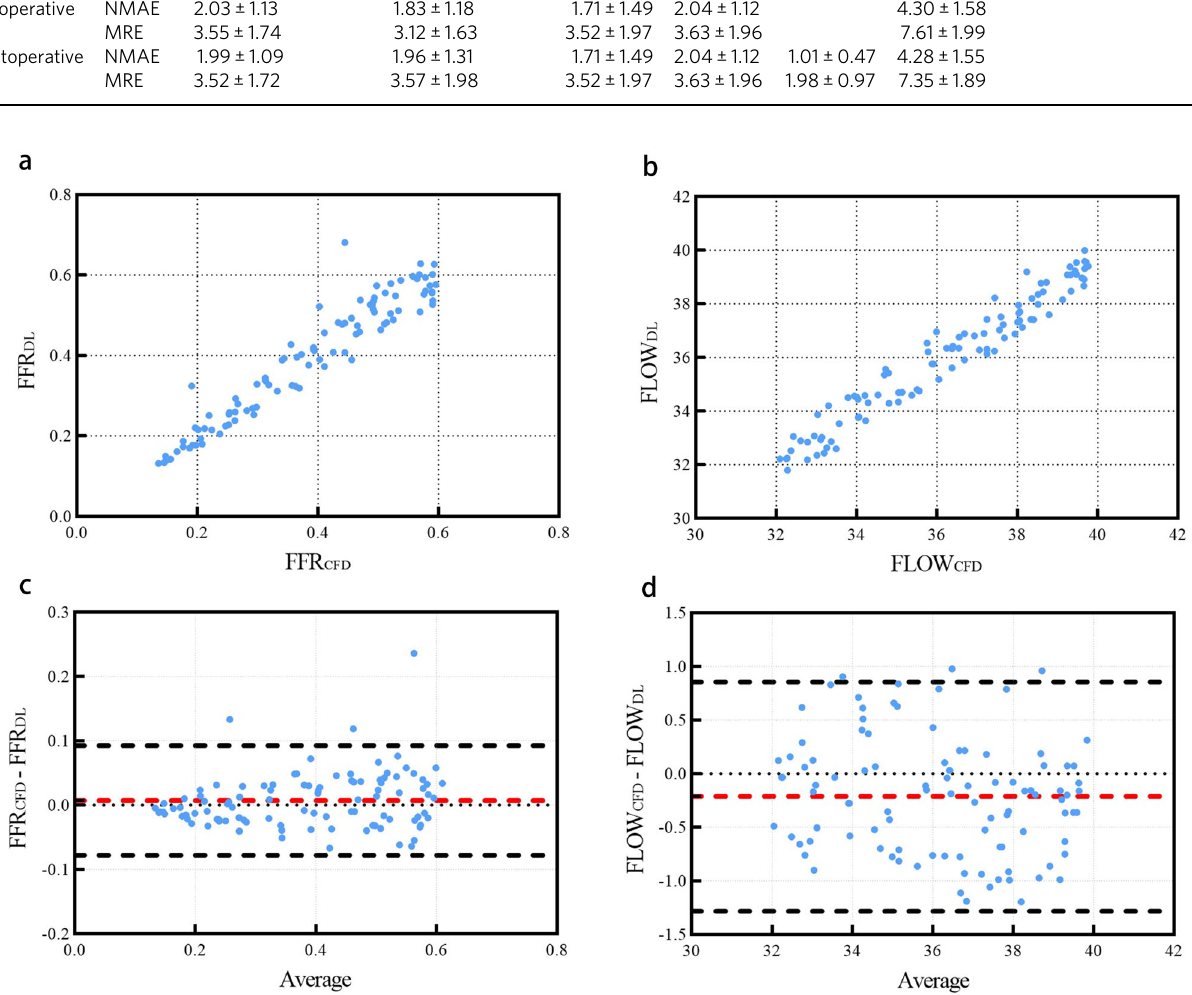
Fig. 3 Comparison of FFR and improved blood fl ow obtained from CFD and deep learning. a Is a scatterplot of FFR values from CFD (FFR CFD ) and deep learning (FFR DL ). b Is a scatterplot of improved blood fl ow values from CFD (FLOW CFD ) and deep learning (FLOW DL ). c , d Are Bland – Altman analysis plot of corresponding ( a , b ). The hemodynamic results used to calculate FFR and improved blood fl ow are from 100 cardiovascular models in the test